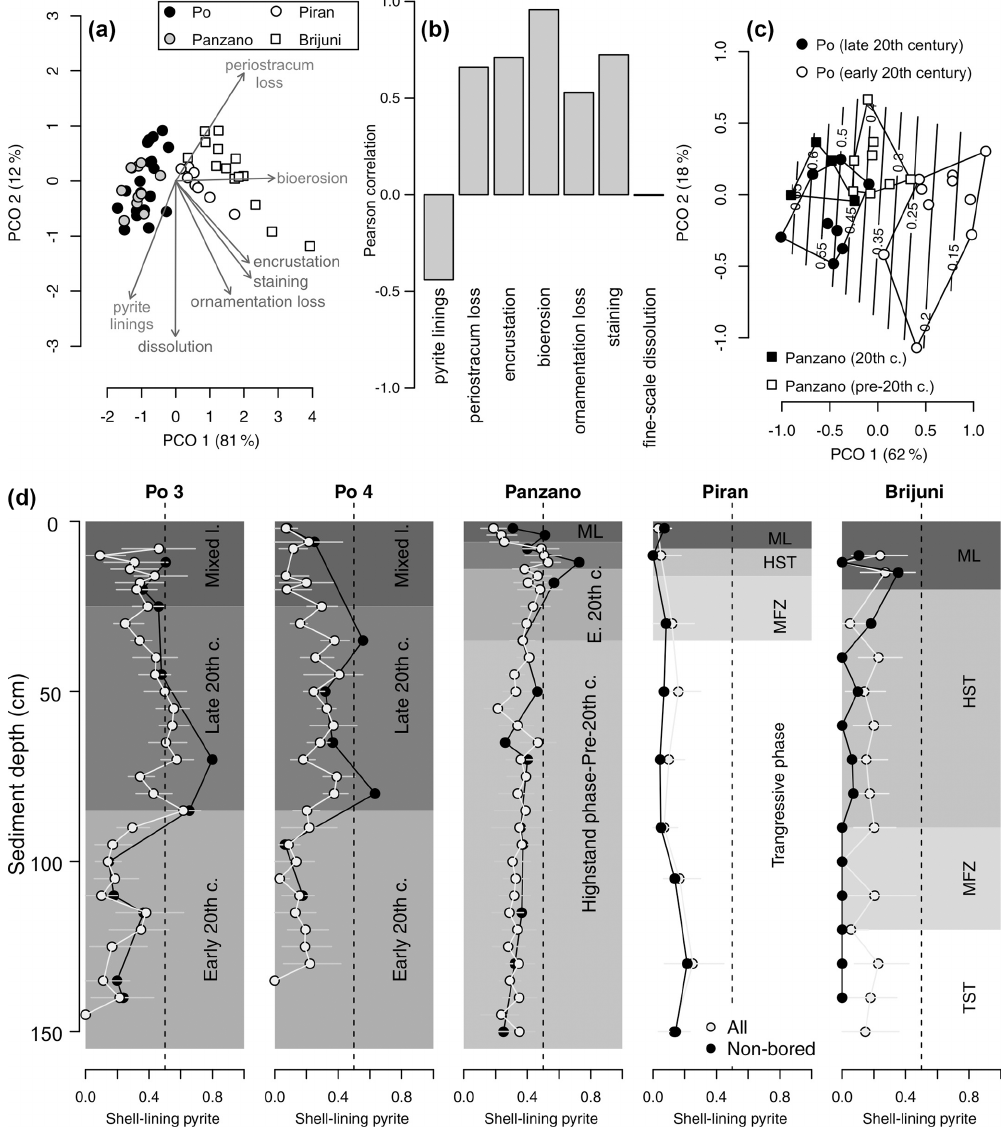
Figure 13. (a) Principal coordinate analysis (PCO) based on V. gibba alteration (using seven variables) in increments from all sites (excluding increments from the mixed layer). (b) Correlations between PCO axis 1 and seven alteration variables show that pyrite varies inversely with other alteration variables. (c) Principal coordinate analysis of increments at Po and Panzano, showing the separation between the latest HST (white circles) and the late 20th century increments (black circles), mainly determined by the frequencies of pyrite-lined specimens (contours). (d) Stratigraphic changes in the frequencies of all pyrite-lined valves (gray circles) of V. gibba peak at 40%–50% in the upper part of cores at Po 3 and Po 4 and at 50% at ∼ 10–20cm at Panzano. The frequencies of pyrite-lined valves are typically less than 20% at Piran and Brijuni where sedimentation rates are slow. The frequencies of pyrite-lined valves at Piran and Brijuni further decline when the frequencies of pyrite-lined valves are limited to valves not affected by bioerosion (black circles), magnifying the contrast between well- preserved pyrite-lined valves at sites with high sedimentation (primary linings) and variably preserved pyrite-lined valves at sites with slow sedimentation (with some pyrite corresponding to secondary